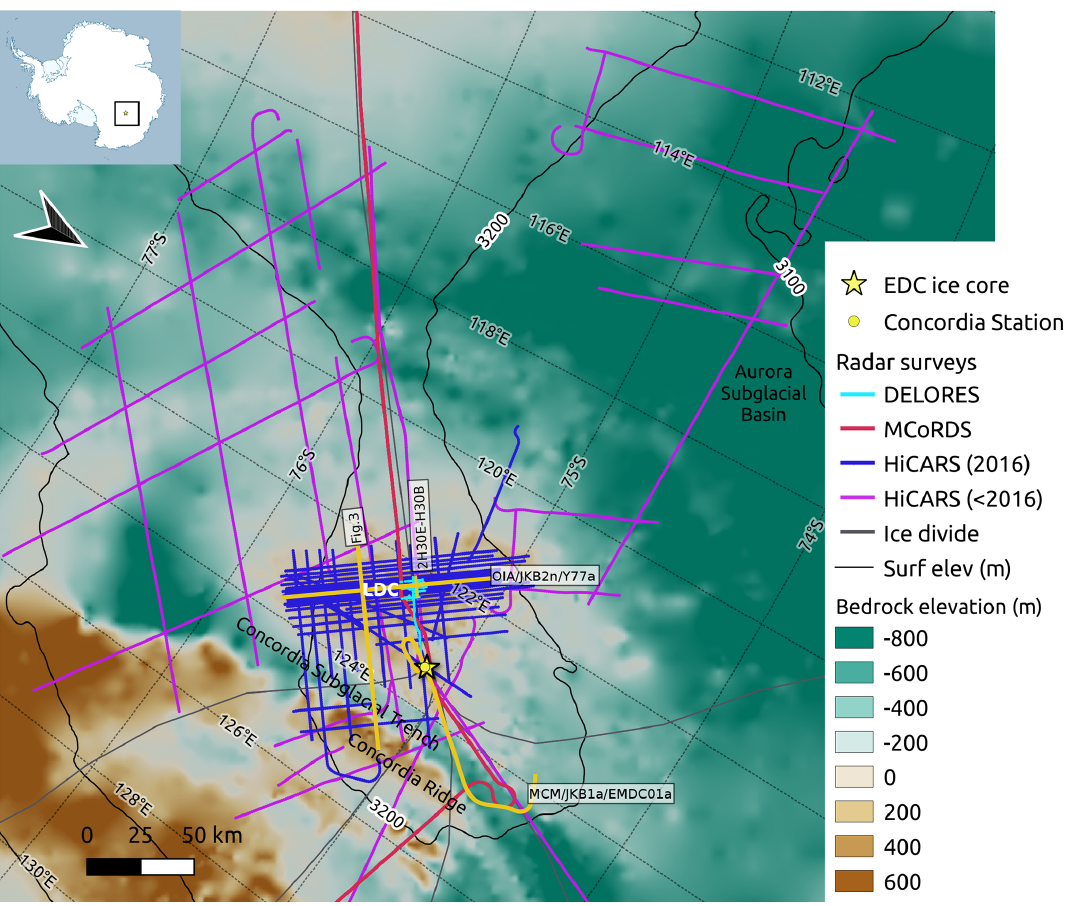
Figure 1. The Dome C region of the East Antarctic plateau with the extent of the ice-penetrating radar surveys used to trace the IRHs, shown as solid lines whose color is shown in the legend. Radar transects discussed are highlighted in yellow. Background is BedMachine Antarctica v1 bedrock topography (Morlighem et al., 2020) with superimposed CryoSat-2 elevation contours (Helm et al., 2014); a yellow star and a yellow circle locate the EDC ice core site and the Concordia Station, respectively (note that they are coincident at this spatial scale); a gray line locates the Rignot et al. (2019) ice divides in the region; the main geographical sites are labeled. The inset locates the study area.